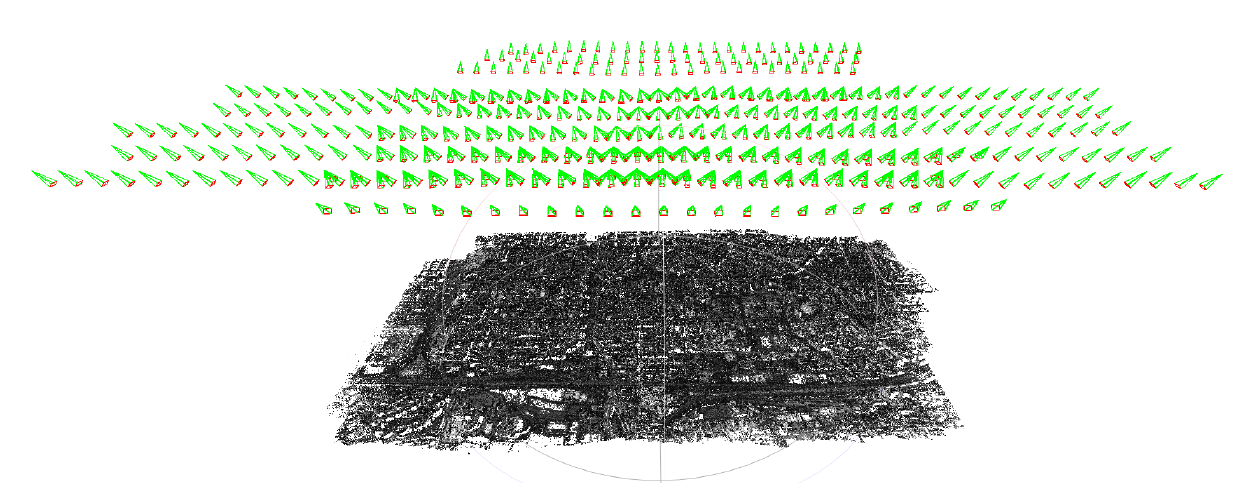
Figure 6: The derived camera poses of the image block over Milano (550